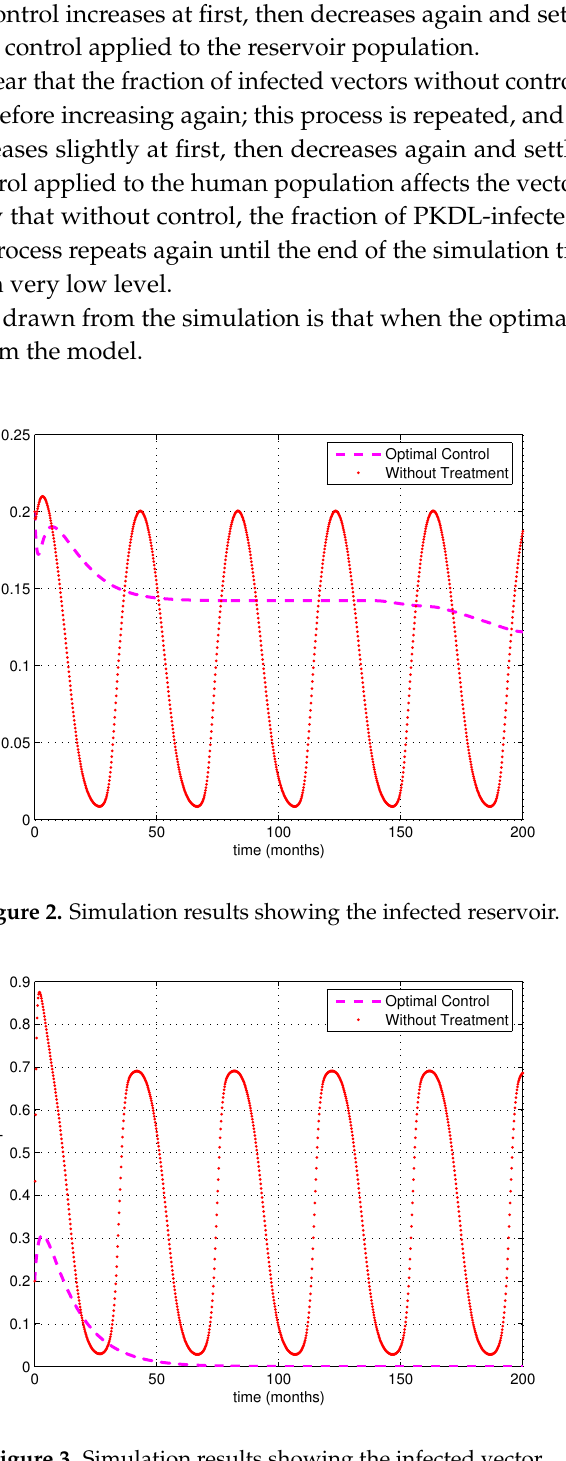
Figure 3. Simulation results showing the infected